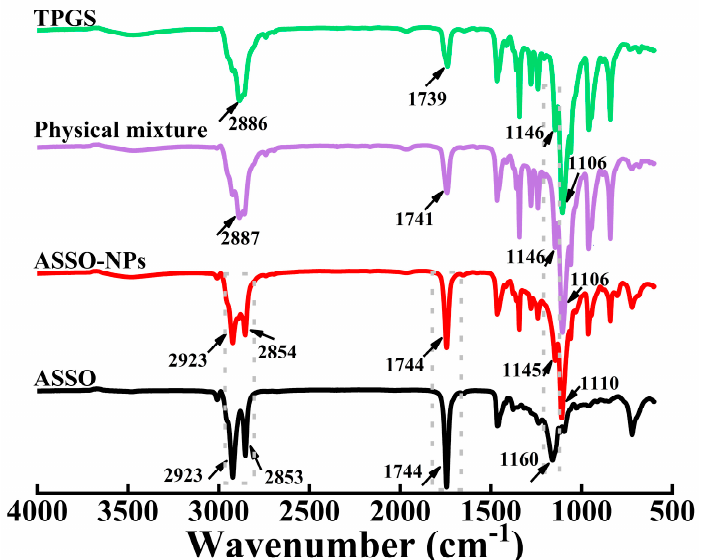
Figure 2. The FT-IR spectra of the ASSO, TPGS, and ASSO-NPs, and the physical mixture of ASSO and TPGS.